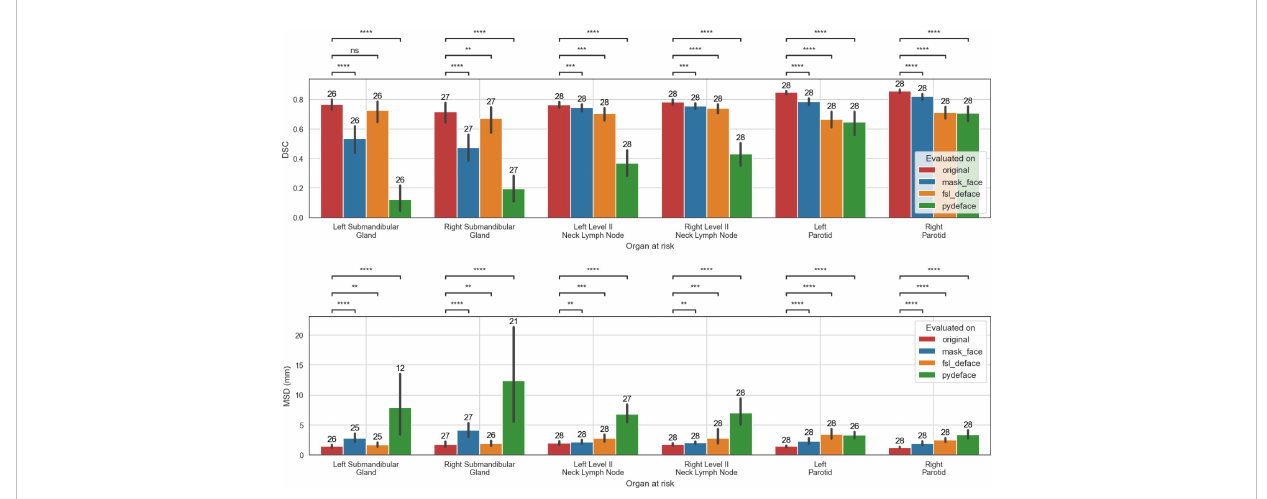
FIGURE 4 The performance of models trained on the original data when evaluated on the original, mask_face, fsl_deface, or pydeface data for the six organs at risk included in the analysis. Only cases that were available for all the methods were included: 28 segmentations were used for all structures except in the case of the left and right submandibular glands where 26 and 27 segmentations were used, respectively. In addition, for the MSD metric, empty model output segmentations were discarded, which resulted in a smaller number of evaluated structures. The number of evaluated structures is shown on top of the barplot. The mean and standard deviation for each metric are represented as the center and extremes of the error bars, respectively. Statistical signi fi cance was measured with Wilcoxon signed-rank tests corrected with Benjamini-Hochberg procedure for all OARs and models. Comparison symbols: ns (p > 0.05), * (p ≤ 0.05), ** (p ≤ 0.01), *** (p ≤ 1e-4), **** (p ≤